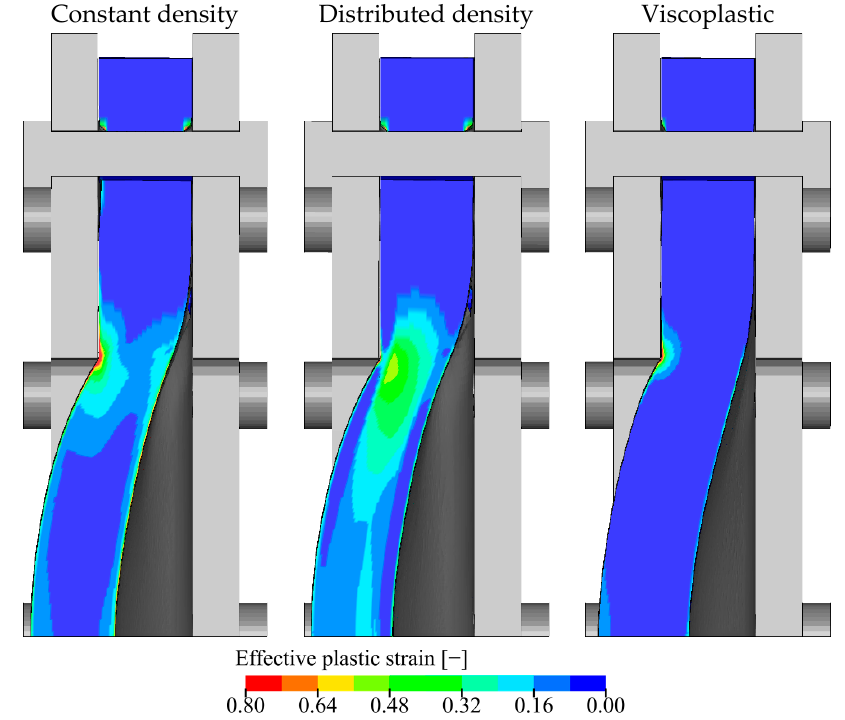
Figure A9. Deformation profiles and plastic strain from numerical simulations of test Sw_400_P12.